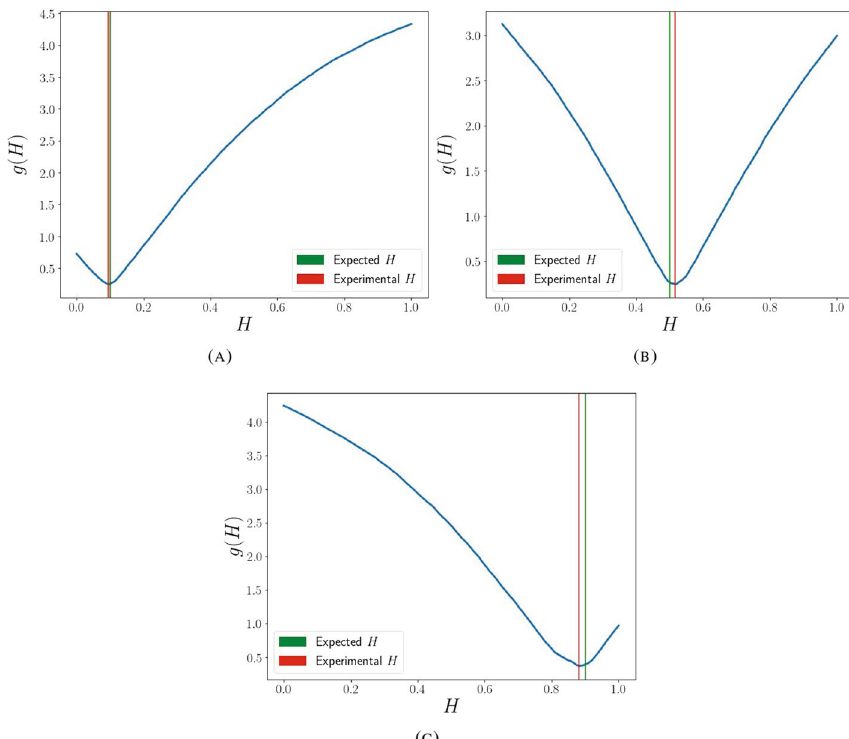
Fig. 3 Graphs of functions g between H = 0 and H = 1 with the KS‑TA method for a fractional Brownian motion with size 2 10 . The Hurst exponents are A 0.1, B 0.5, and C